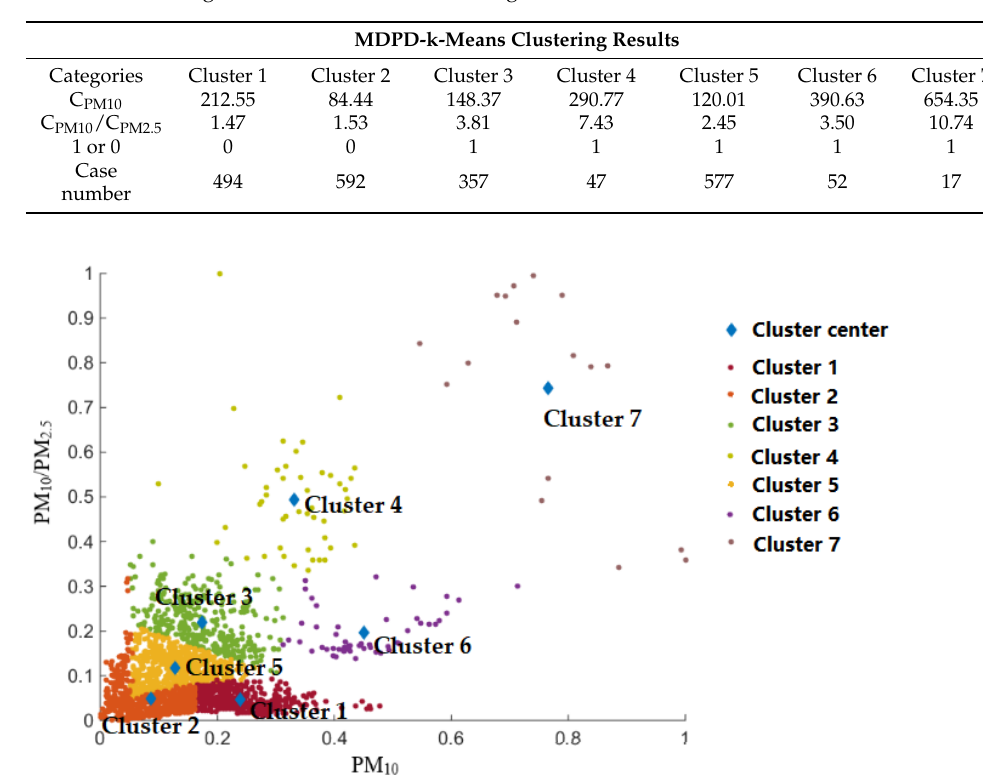
Figure 3. Clustering sample distribution of MDPD-K-means algorithm (Coordinate system based on the normalized scale).